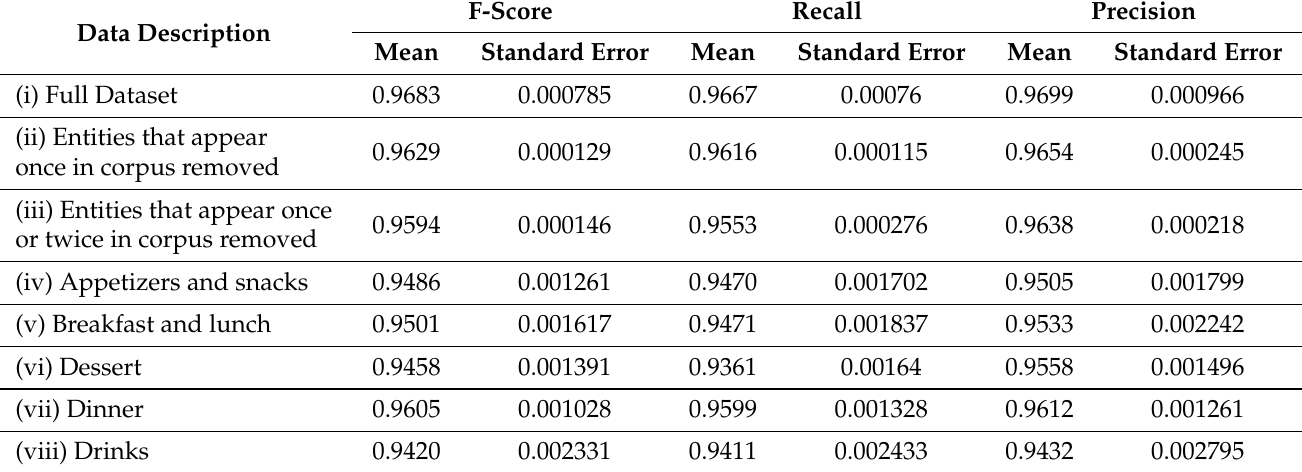
Table 2. Results for the CRF model assessed with a 10-fold CV. Datasets include (i) full corpus data, (ii) data with entities that appear just once are removed, (iii) data with entities that appear just once or twice are removed and (iv) appetizers and snacks, (v) breakfast and lunch, (vi) desserts, (vii) dinner and (viii)